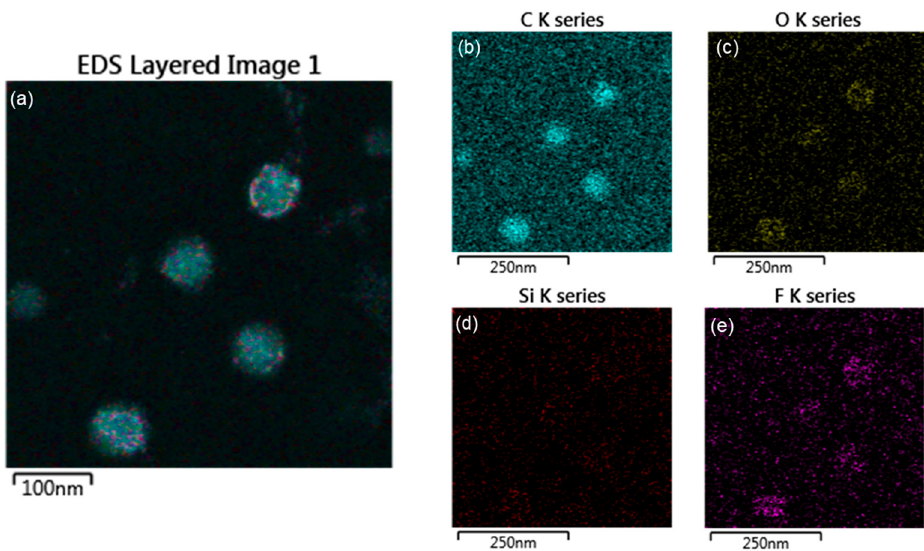
Figure 6 . EDAX elemental mapping images of the TCR-1 sample. ( a ) EDS layered image, ( b ) C series, ( c ) O series, ( d ) Si series, and ( e ) F series (blue represents the C component, yellow represents the O component, red represents the Si component, and purple represents the F component in the mapping images).